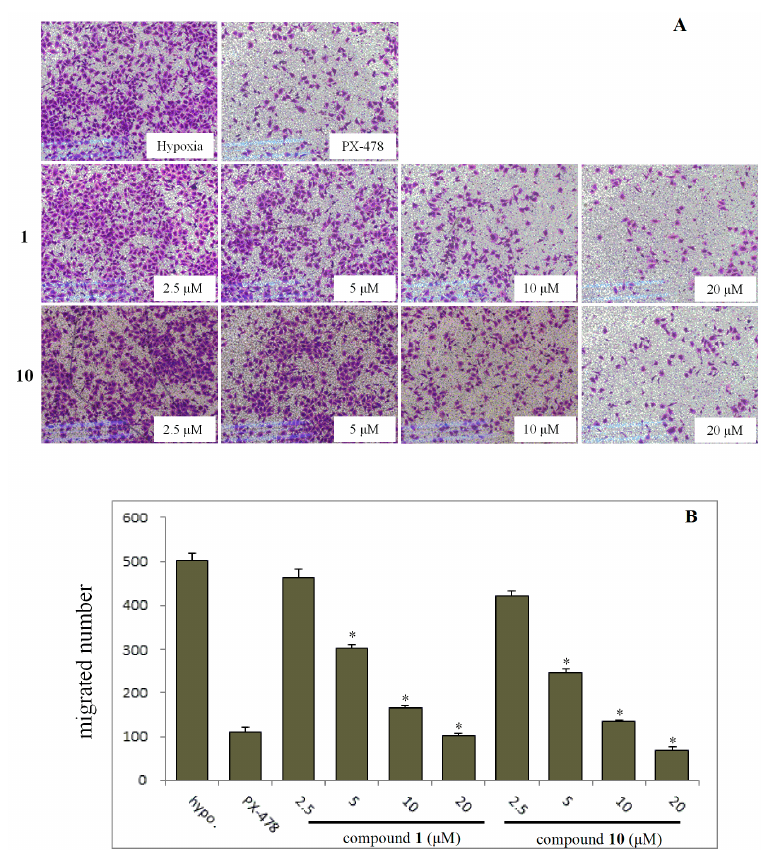
Figure 2. Effects of selected compounds 1 and 10 under the lower concentration gradient with positive control (PX-478) on migration of SMMC7721 cells under hypoxia conditions by transwell assays. 1 × 10 5 cells were seeded onto the transwell migration chamber and exposed to compounds for 24 h. ( A ) The migrated cells at the lower side of the membrane were then stained using Crystal Violet. ( B ) The quantification analysis. Column: mean; bar: standard deviation; n = 3. * p < 0.05 compared with the control.